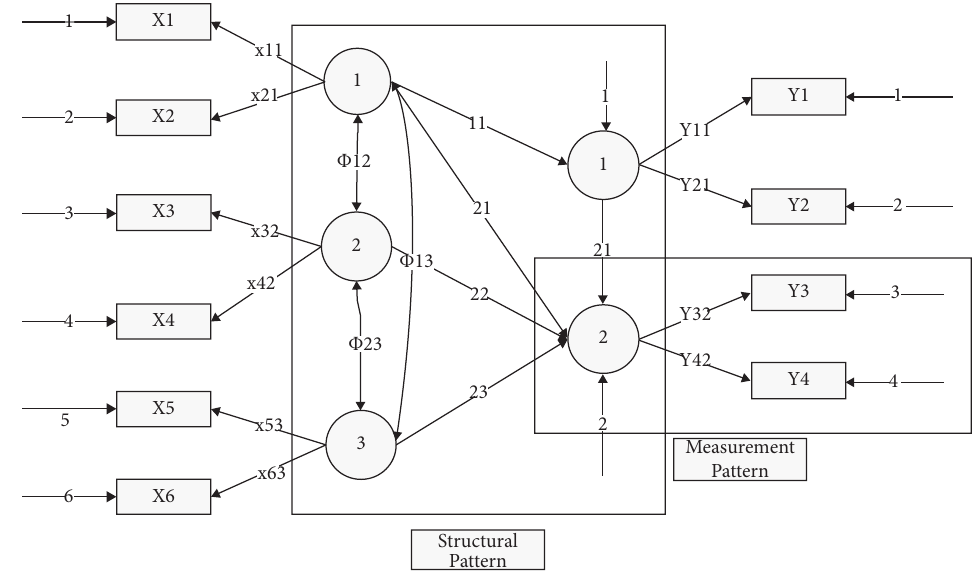
Figure 1: Structural and measurement patterns in